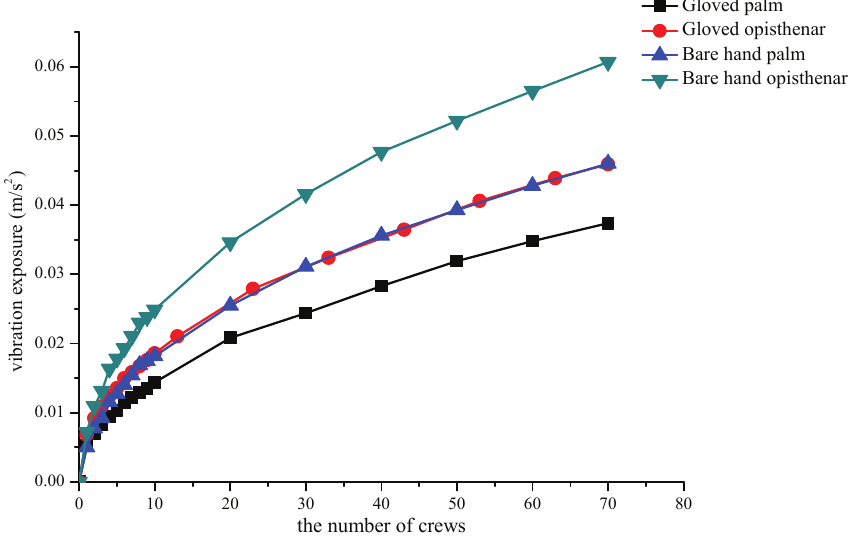
Figure 8. The vibration exposure in the composite state of a power tool using a 400 mm operating rod varies with the number of